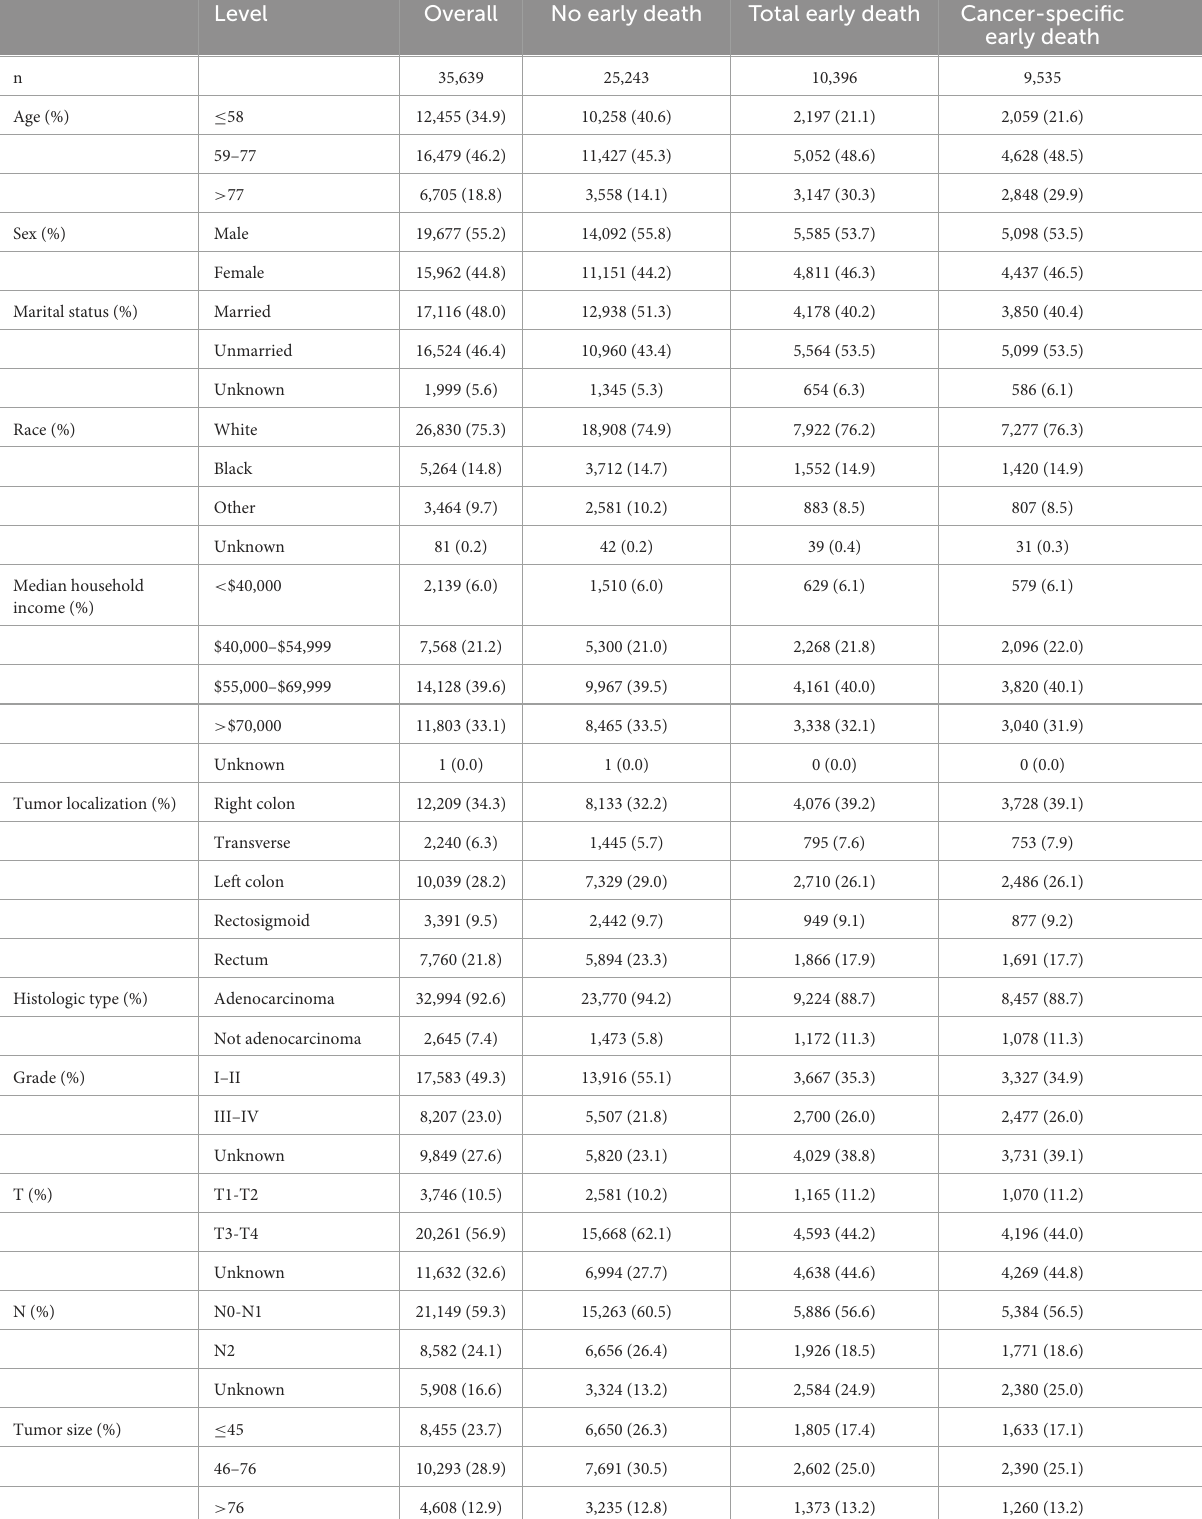
TABLE 1 Demographic information of patients with mCRC. Level Overall No early death Total early death Cancer-specific